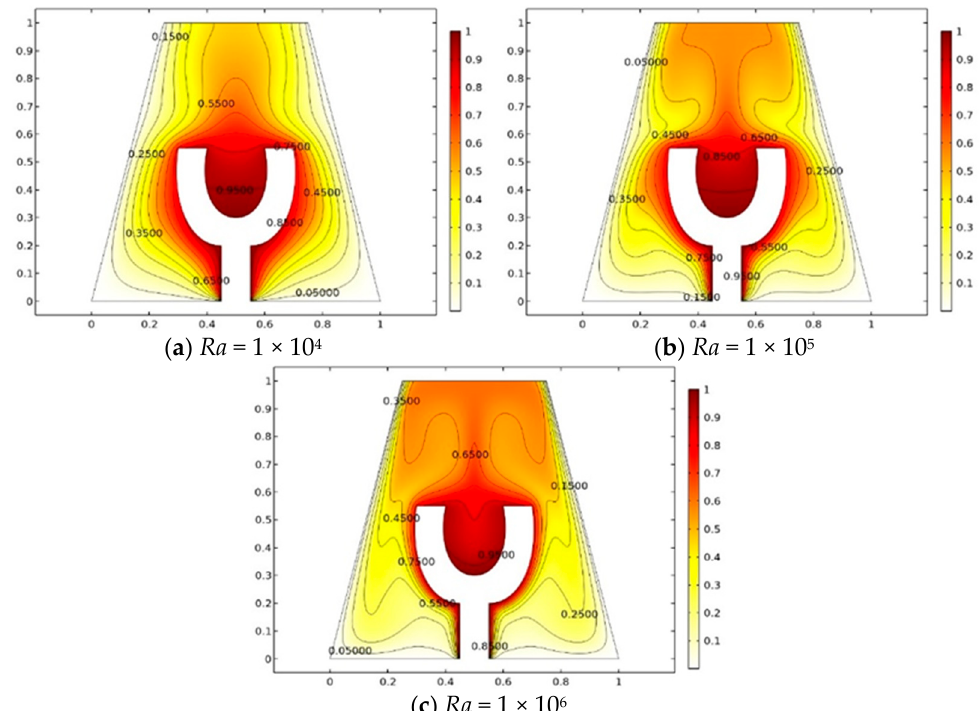
Figure 5. Temperature profile and isothermal contours for varying (𝑅𝑎) at 𝑛 = 1 and 𝑃𝑟 = 5 .